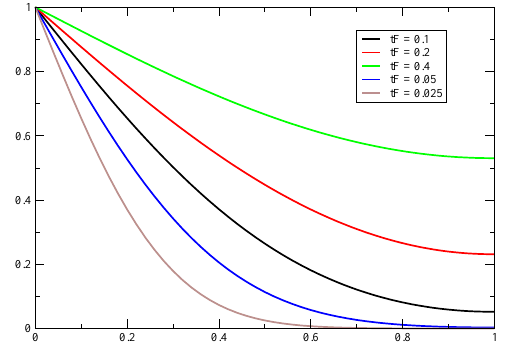
Figure 1. Temperature at different time moments: t j = 0 . 025 j , j = 1 , 2 , 4 , 8 , 16